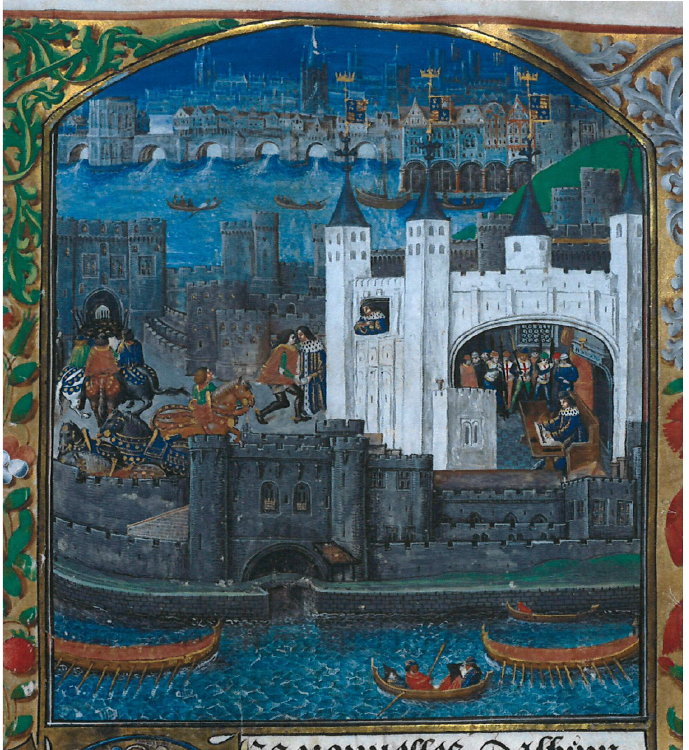
Fig. 9. View of London with London Bridge and the Tower, late fifteenth century. London, British Library Royal MS. 16 F. II, f.